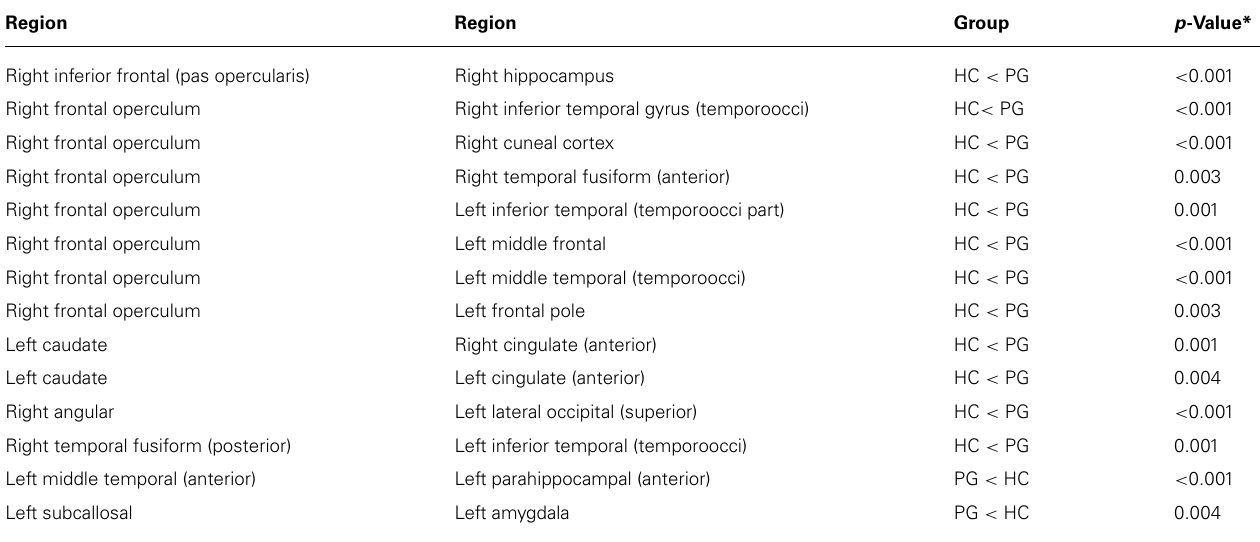
Table 3 | Significant differences between pathological gamblers (PG) and healthy controls (HC) in functional